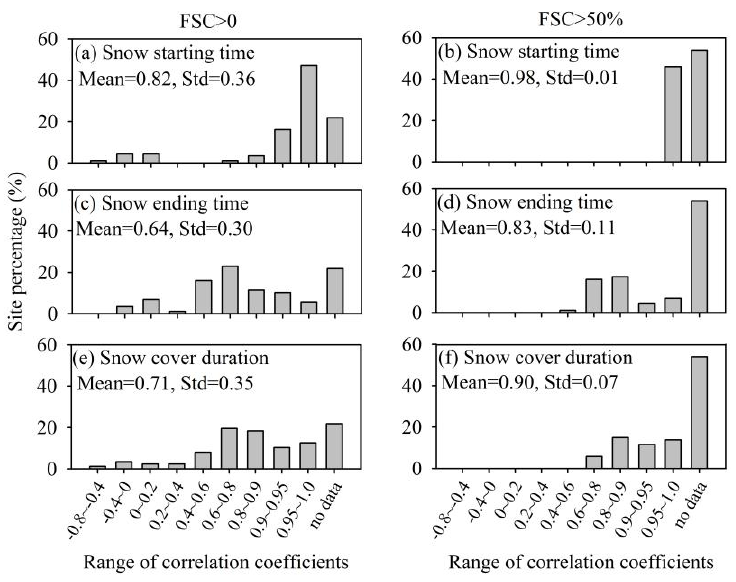
Figure 10. Site percentage of correlation coefficients (r) between in situ and MODIS data-derived interannual variability of snow phenology (i.e., snow starting time, snow ending time, and snow cover duration) on the threshold of FSC >0 and FSC >50%. Mean and Std in the graph indicate the mean value and standard deviation of r. Table 2. Long-term change trends of annual snow starting time, snow ending time, and snow-cover duration for in situ data and daily cloud-free MODIS data (FSC >0 and FSC >50%) from 2000 to 2010.